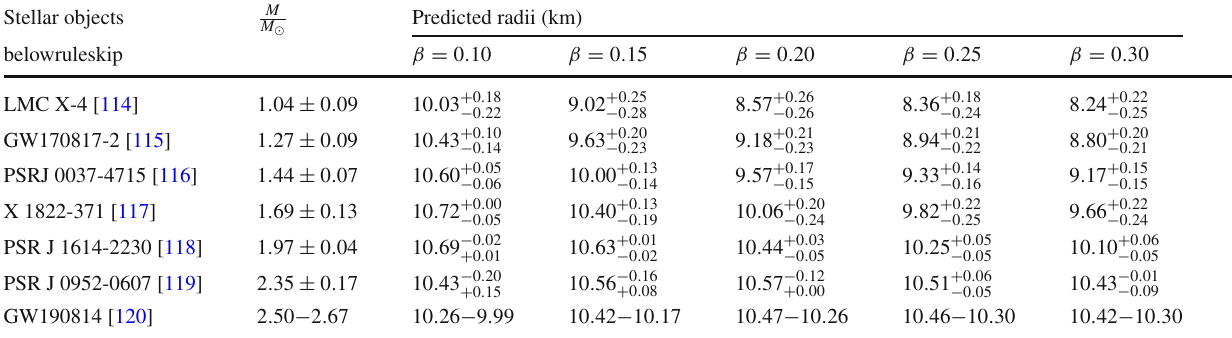
Table 4 Numerical values of the predicted radii of different stars for Solution 5.2 with surface density ρ s (cid:12) 8 × 10 14 gm / cm 3 , A = 0 . 0078 , B = 0 . 0093 ,α = 1 . 2 Stellar objects M Predicted radii (km) M (cid:8)